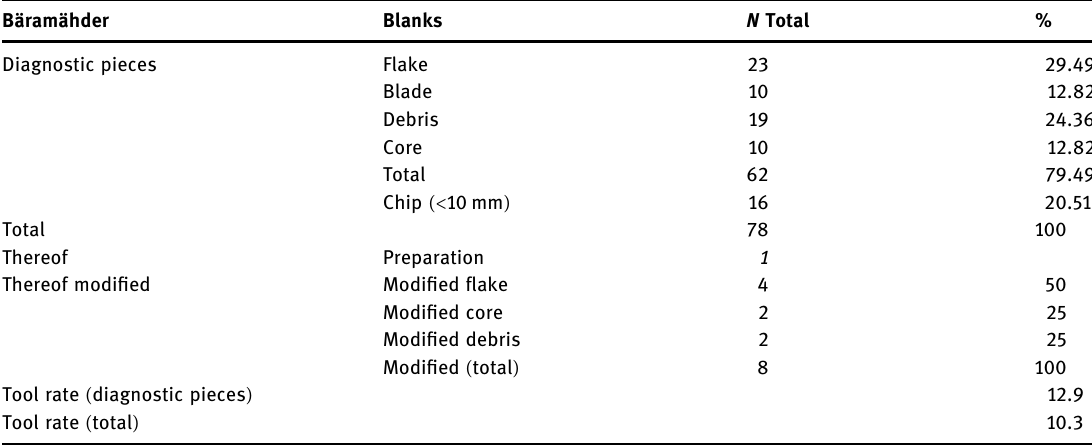
Table 8: Lithic assemblage Bäramähder Bäramähder